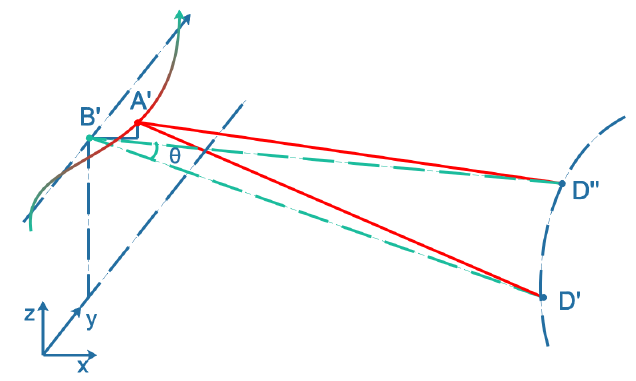
Figure 4. Aperture-dependent motion